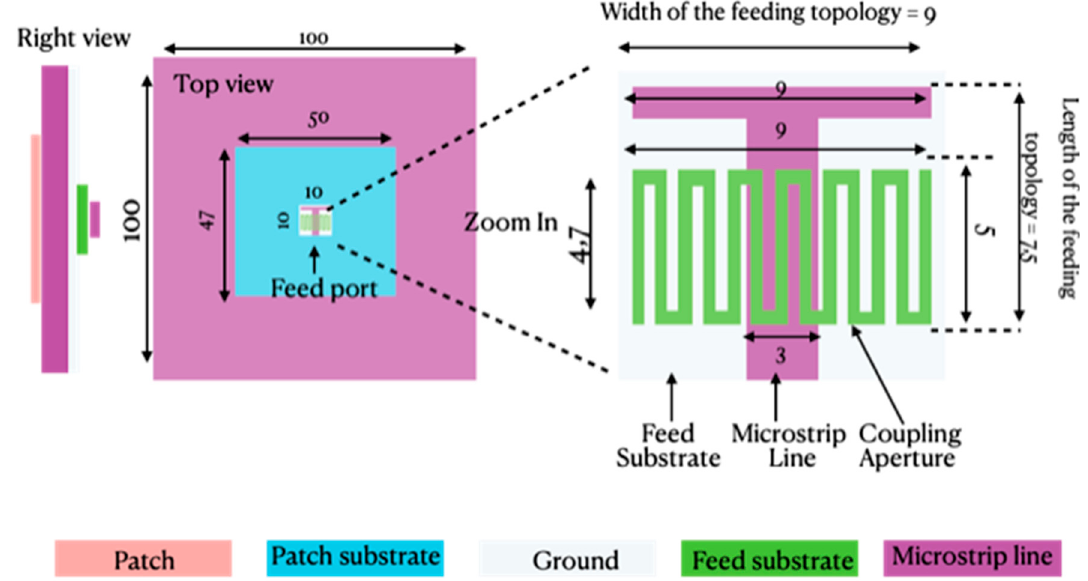
Figure 3. Feeding network of a patch antenna; design based on [8]. ( Left ): complete antenna. ( Right ): miniature feeding network. Dimensions are in